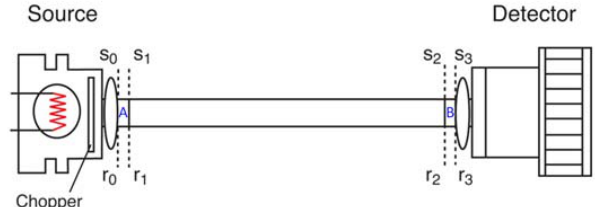
Fig. 1. General layout of an infrared gas analyser optical path. Sym- bols s i and r i represent optical power in the sample and reference paths, respectively, at position i in the path. The sample and ref- erence paths can be in the same physical space but with different wavebands, as in a dual-wavelength, single-path instrument (e.g. LI- 7500); or in the same waveband but in different physical paths, as in a dual-path, single-wavelength instrument (e.g. LI-7000). The paths between S 0 and S 1 (window A) and between S 2 and S 3 (window B) represent windows, while the path between S 1 and S 2 represents the gas flow